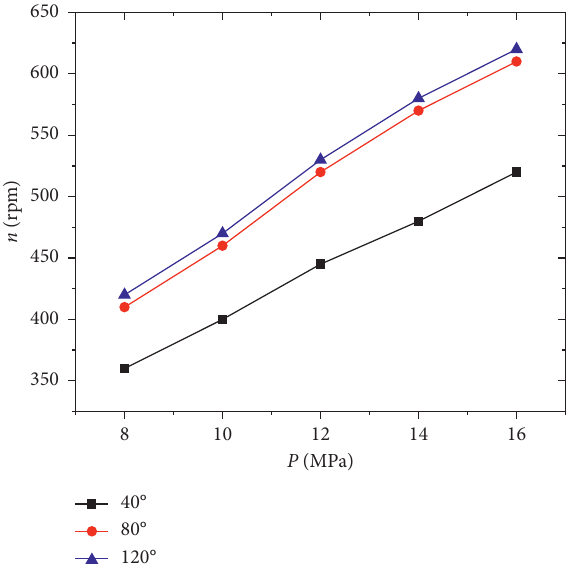
Figure 2: Relationship between pressure and rotating speed.